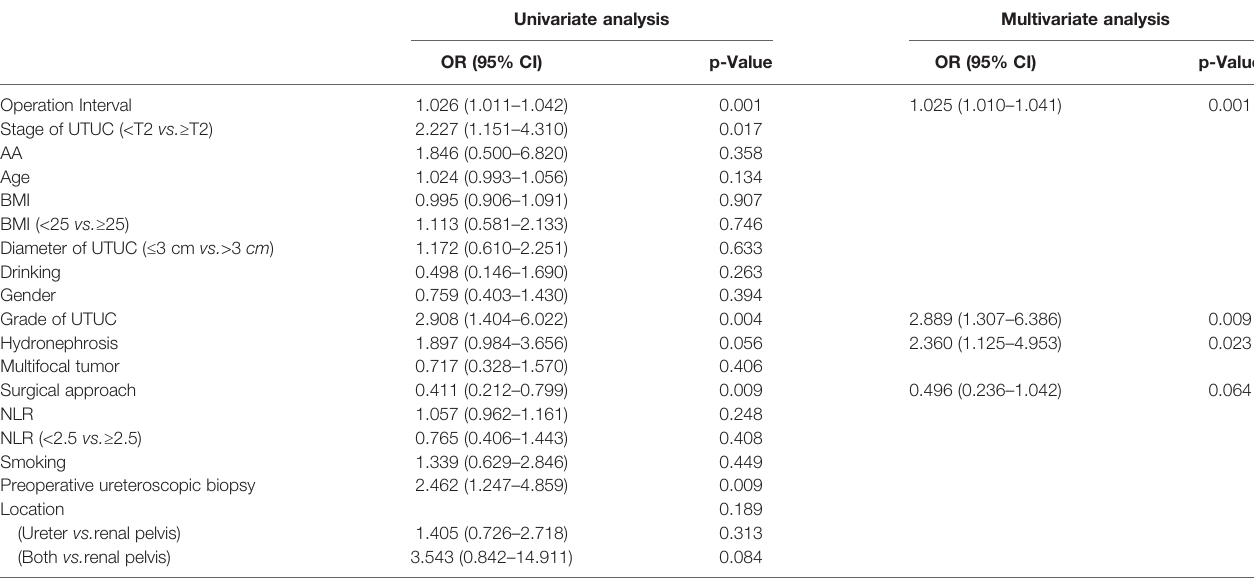
TABLE 6 | Univariate and multivariate analyses for factors associated with MIBC and/or HGBC after RNU.